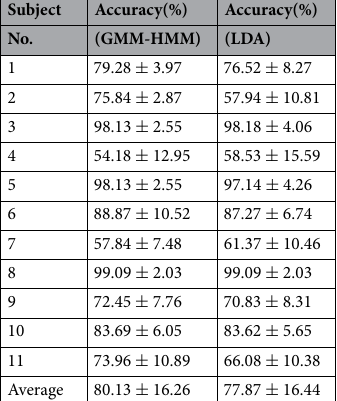
Table 3. Comparison of the recognition performance of idle states. Accuracy is reported as mean standard deviation ±